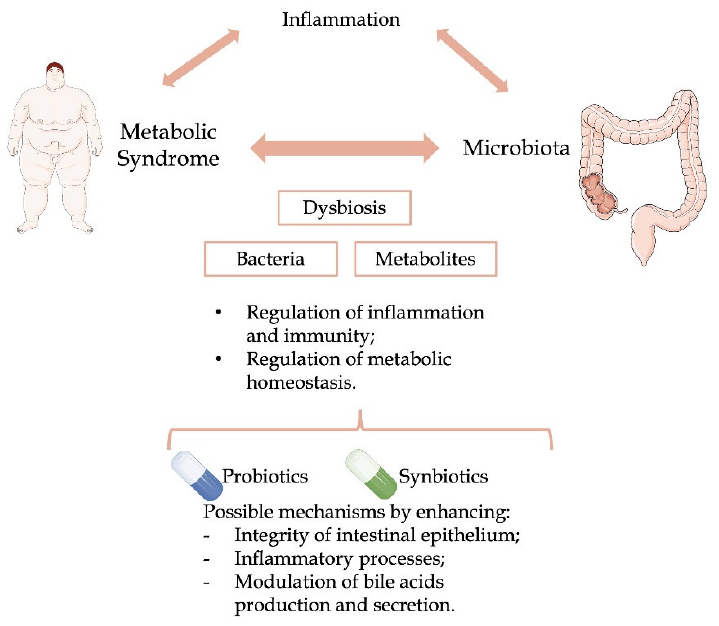
Figure 1. Mechanisms and modulation of the relationship between metabolic syndrome, human microbiome, and inflammation.